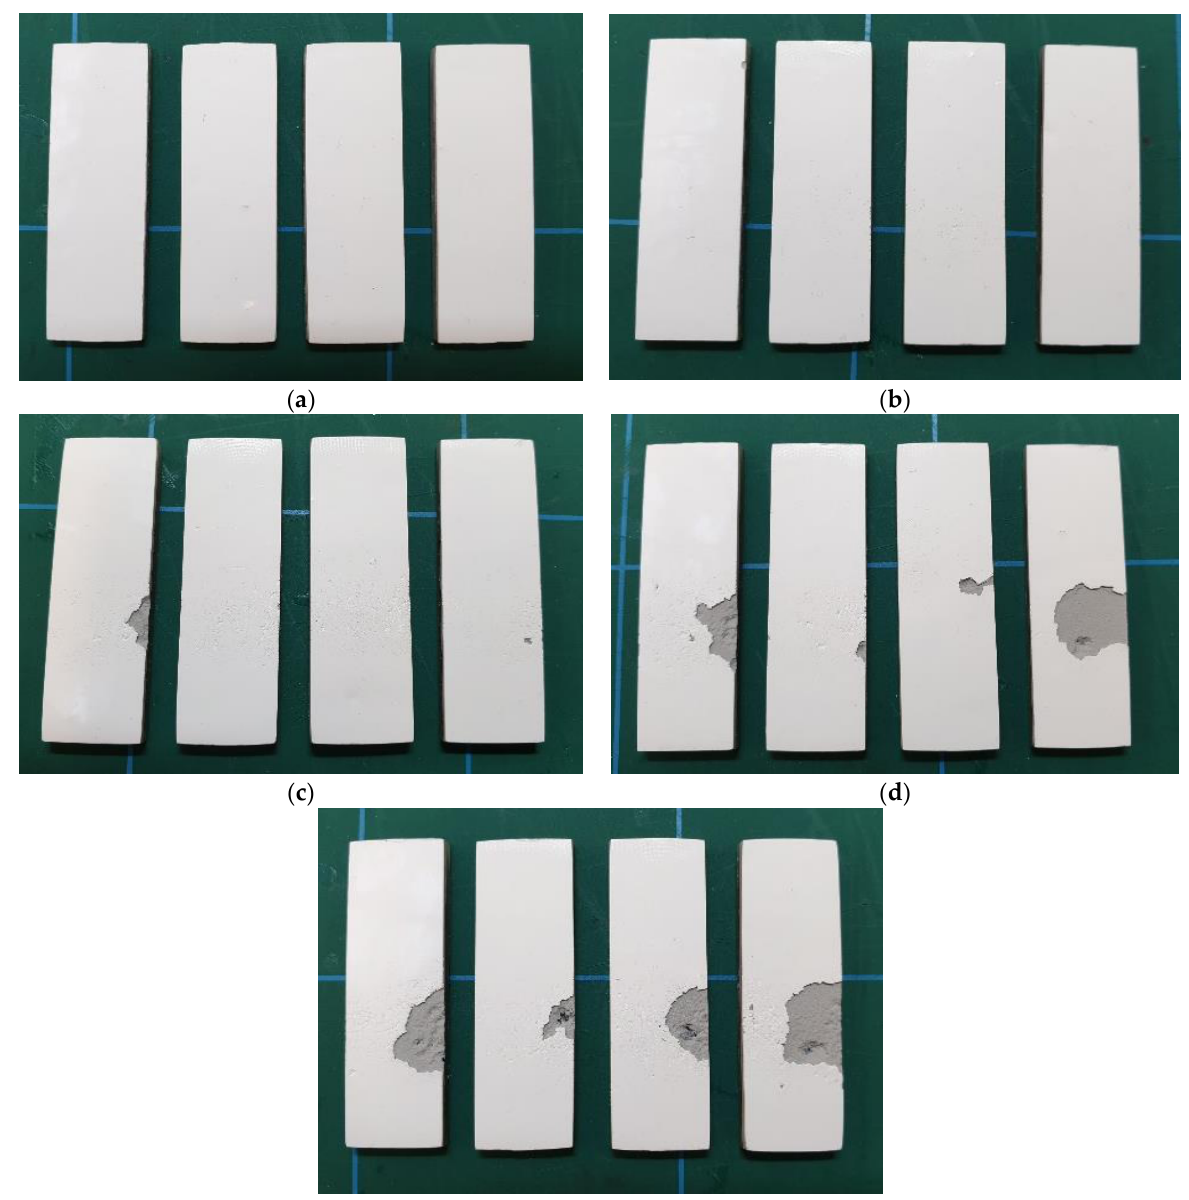
Figure 3. Photographs of samples from each erosion stage: ( a ) Stage 1; ( b ) Stage 2; ( c ) Stage 3; ( d ) Stage 4; ( e ) Stage 5.